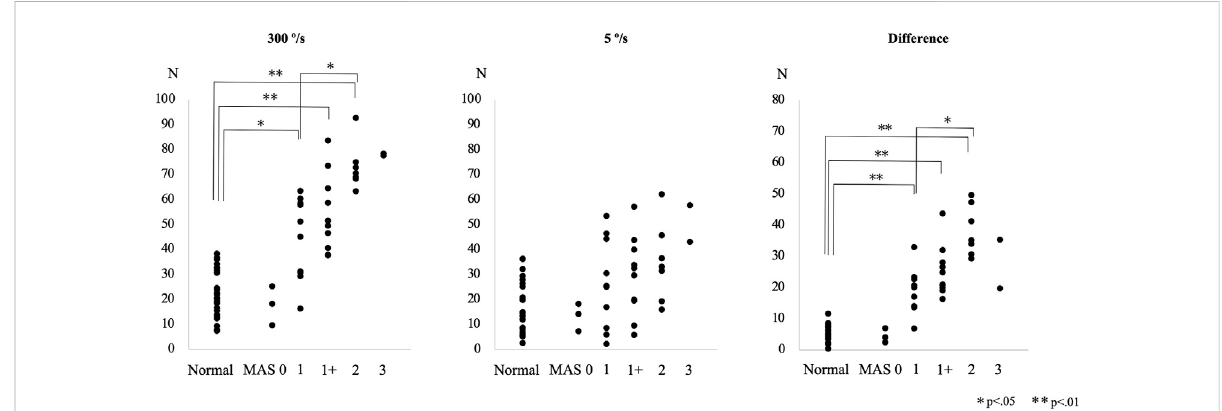
FIGURE 3 Peak resistance force values at angular velocities of 300 ° /s and 5 ° /s and their differences are shown for the control and the patient subgroups, classi fi ed according to the Modi fi ed Ashworth Scale (MAS) score, in Experiment 3.